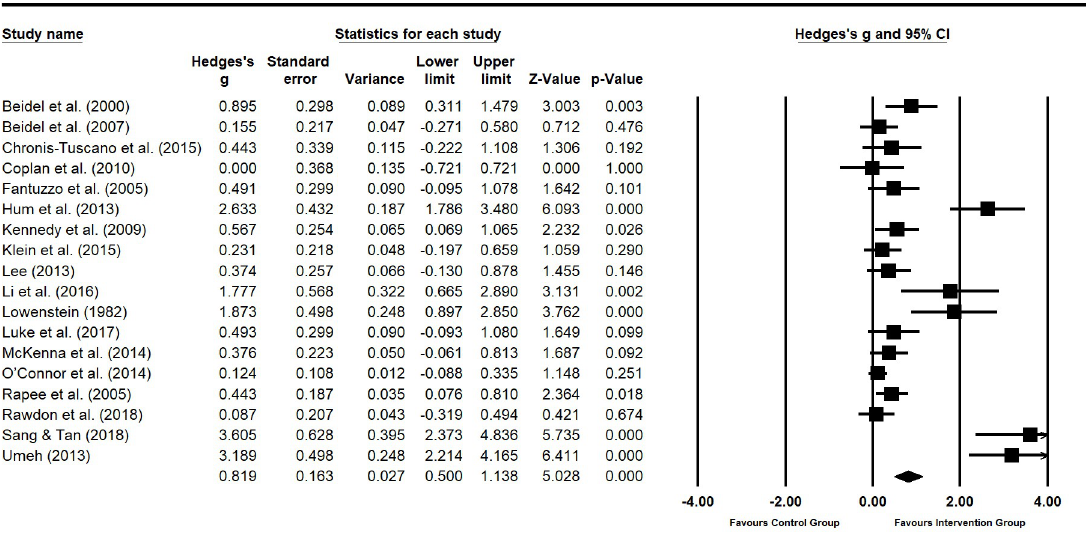
Fig 3. Between-group experimental vs. control intervention group meta-analysis.